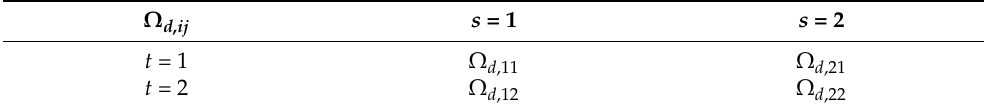
Table 2. Dynamic stability under four conditions.